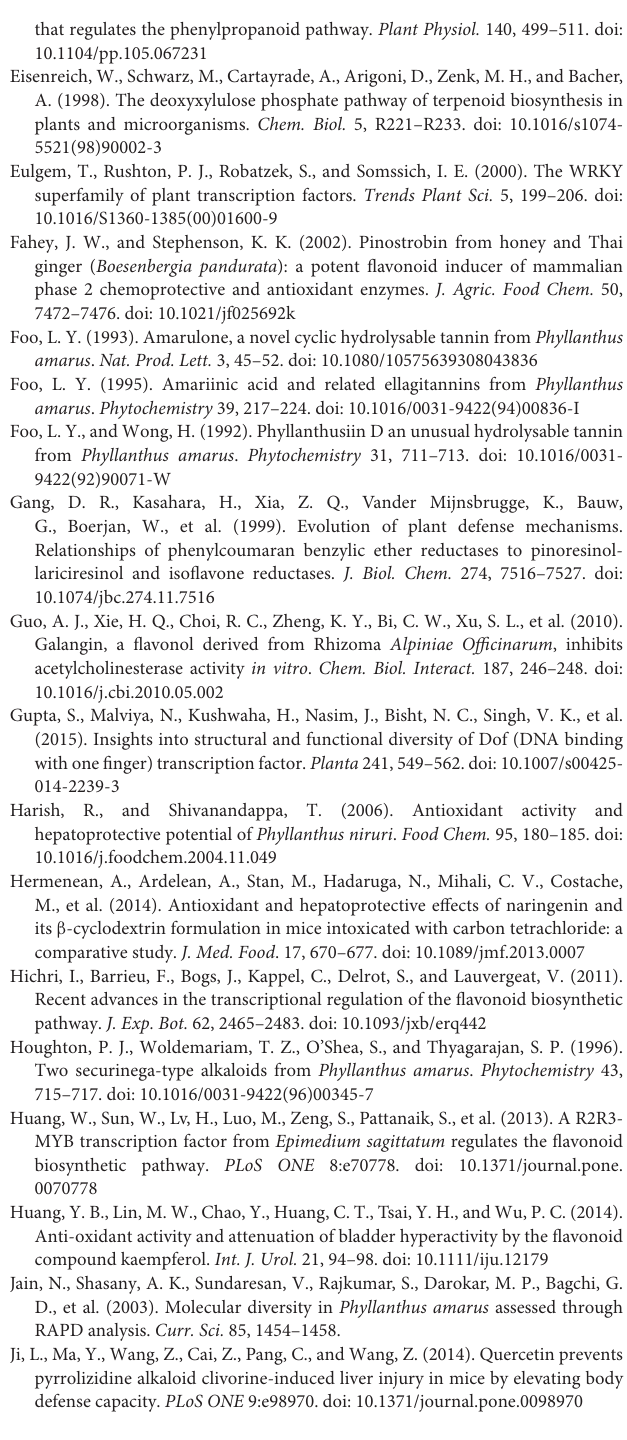
Supplementary Figure 1 | Summary of filtration report of total raw reads generated and used for transcriptome assembly. Supplementary Figure 2 | Terpenoid biosynthesis pathway. Supplementary Figure 3 | Isoquinoline alkaloid biosynthesis pathway.